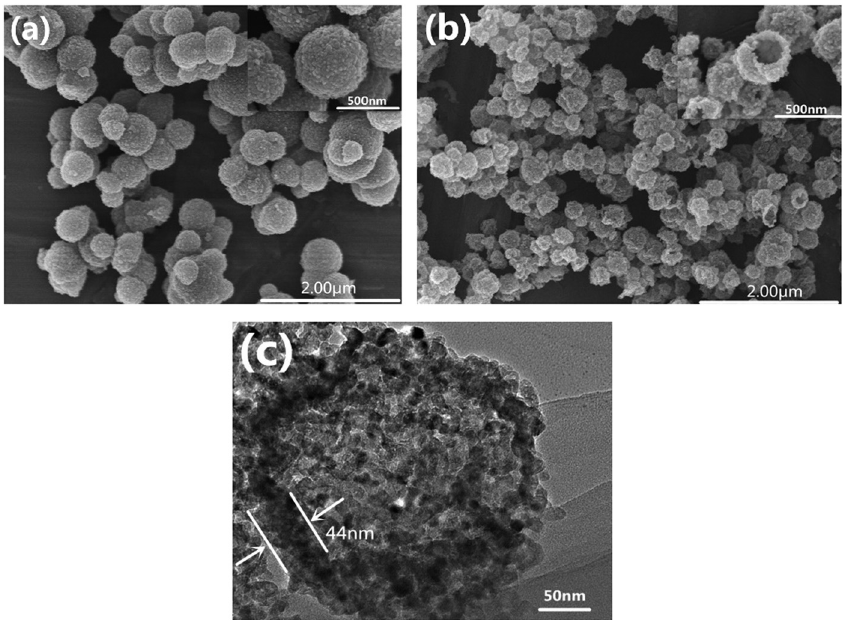
Figure 9: FESEM images of TiO 2 – C and hollow TiO 2 microspheres and FETEM images of hollow TiO 2 microspheres: ( a ) TiO 2 – C; ( b and c ) hollow TiO 2